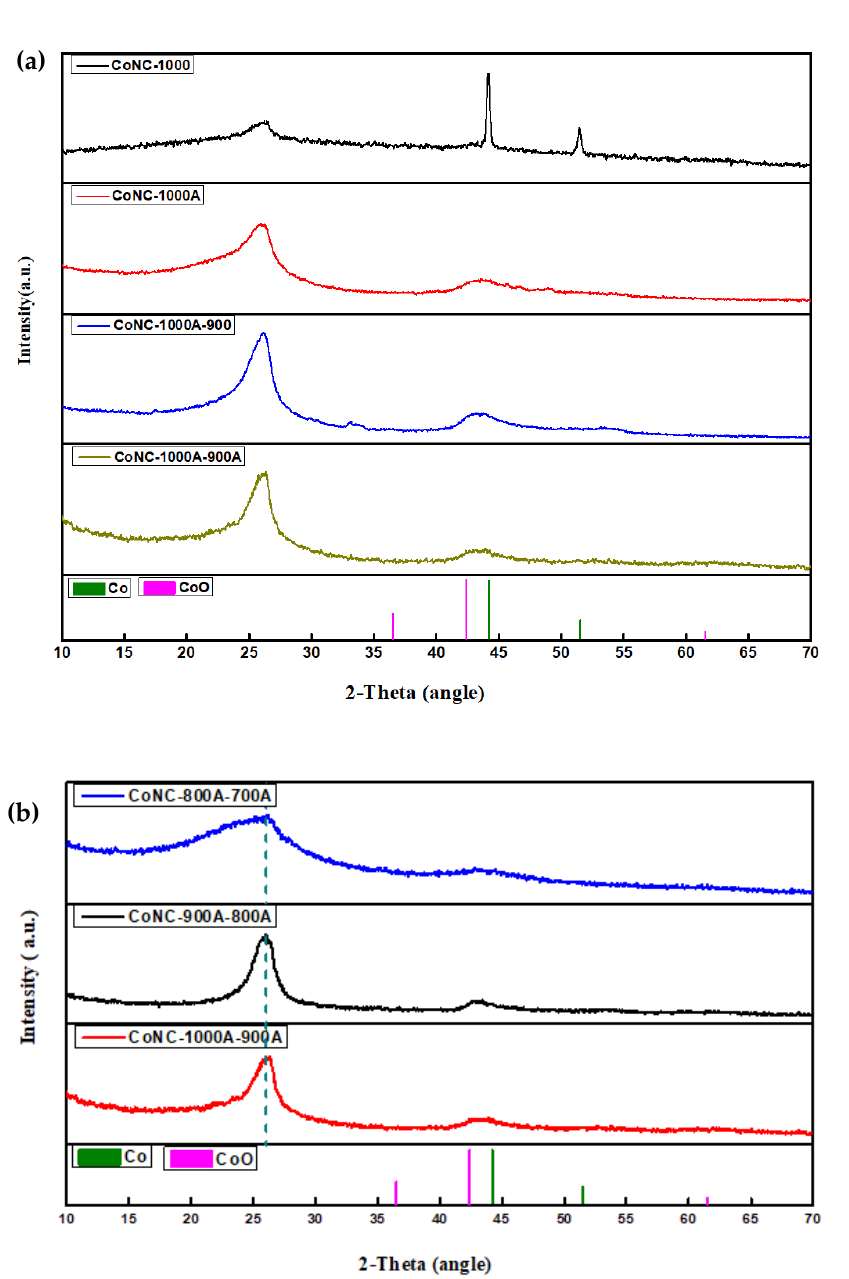
Figure 4. X-ray diffraction patterns of Co-N-C catalysts ( a ) treated at 1000 o C ( b ) and with two-stage calcination double acid